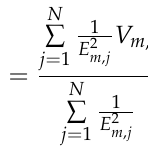
Figure 14. The wind retrieval precision of the four lines.